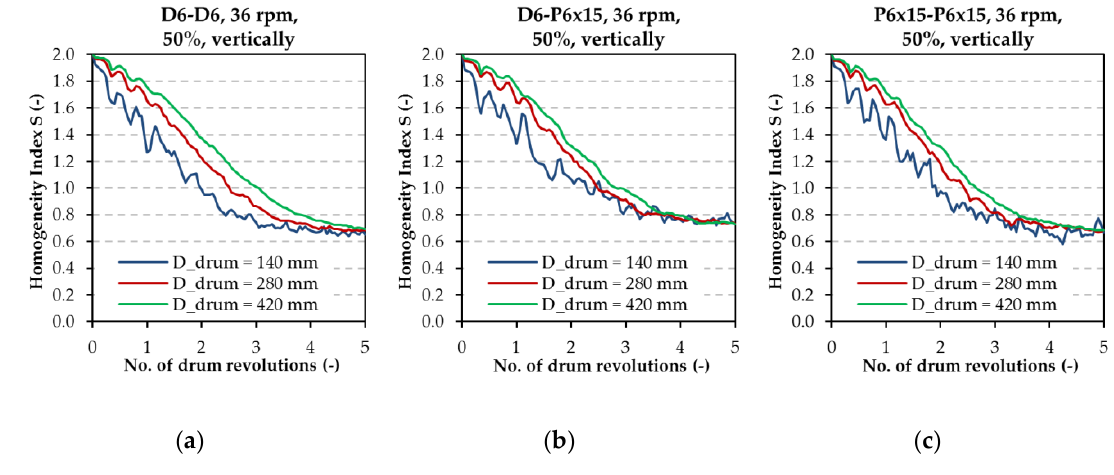
Figure 15. Homogeneity index curves for selected combinations of particles and drum sizes: ( a ) D6-D6, 36 rpm 50%, vertically; ( b ) D6-P6 × 15, 36 rpm, 50%, vertically; ( c ) P6 × 15-P6 × 15, 36 rpm, 50%, vertically.